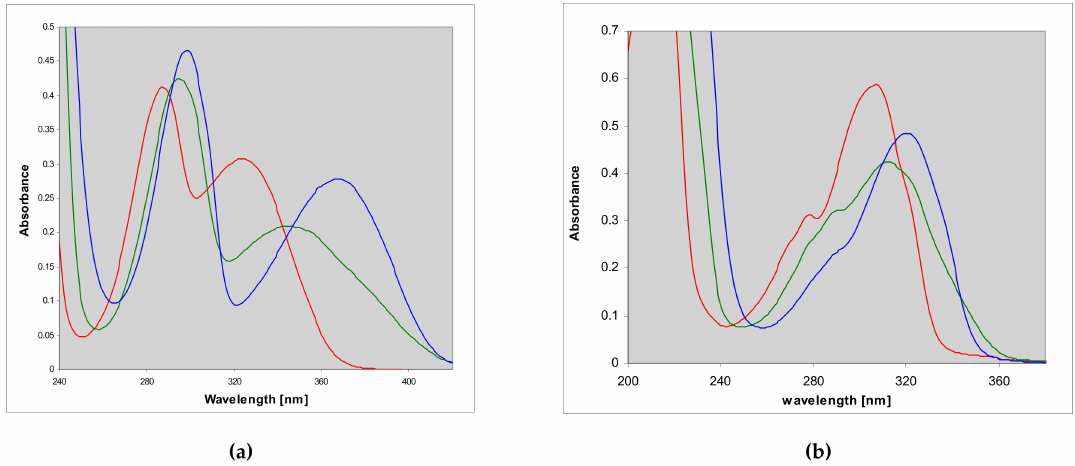
Figure 2. etheno-2-aminopurine ( 2 ) in aqueous medium at various pH: red curves—pH 3; green—pH 7; blue—H